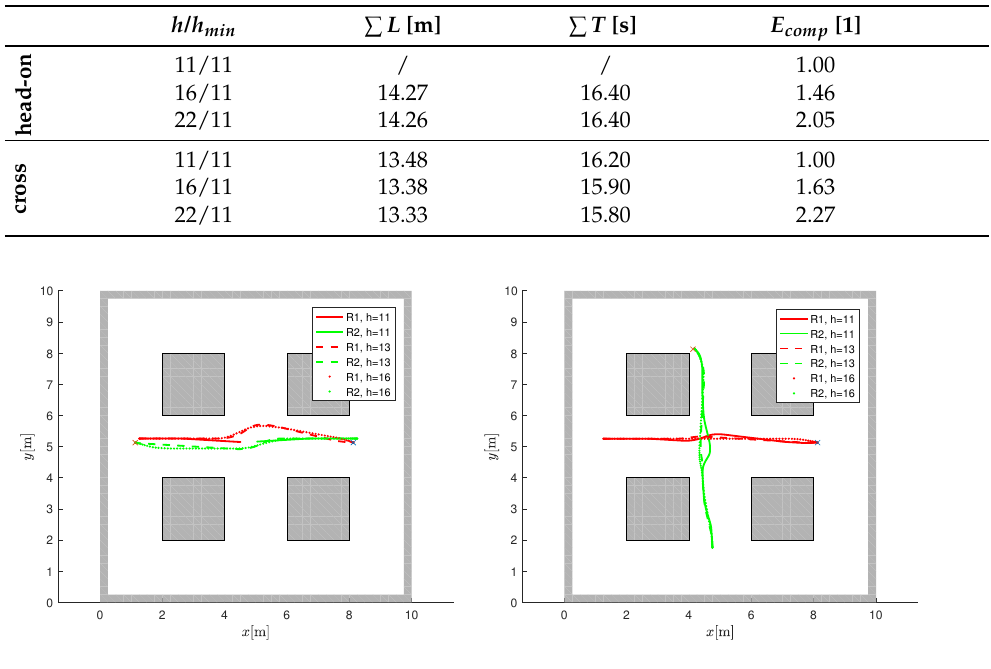
Figure 10. Analysis of horizon length in frontal collision avoidance (left) and cross collision avoidance (right). The target locations are indicated by a cross. A larger prediction horizon can find better trajectories than the minimum horizon h min =